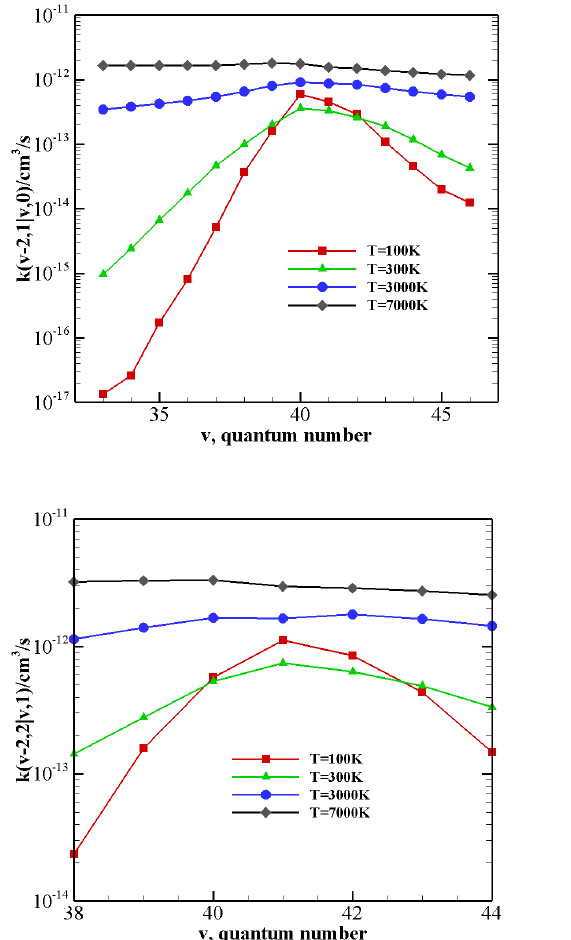
Figure 7. V–V rate coefficients for the near-resonant asymmetric transitions as a function of the vibrational quantum number v at different temperature values. ( upper panel ) CO ( v − 2 ) + N 2 ( 1 ) → CO ( v ) + N 2 ( 0 ) ; ( lower panel ) CO ( v − 2 ) + N 2 ( 2 ) → CO ( v ) + N 2 ( 1 )